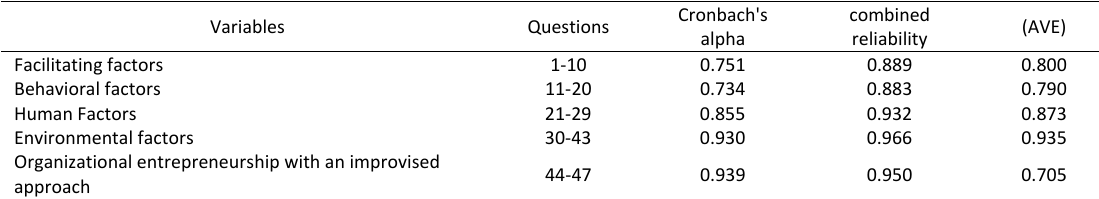
Table 1: Cronbach's alpha, combined reliability and Average Variance Extracted (AVE) Table 1: Cronbach’s alpha, combined reliability and Average Variance Extracted Variables